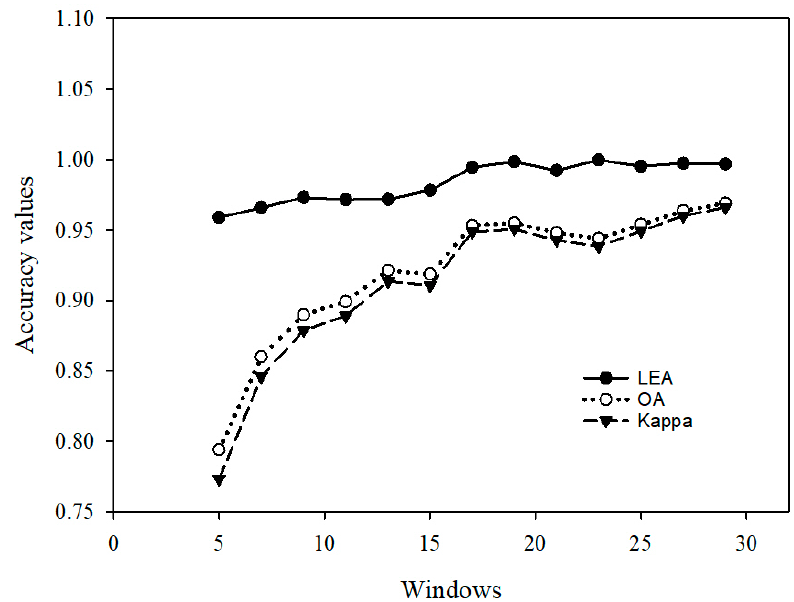
Figure 7. Changes of classification accuracy using the prototypical networks in different windows.